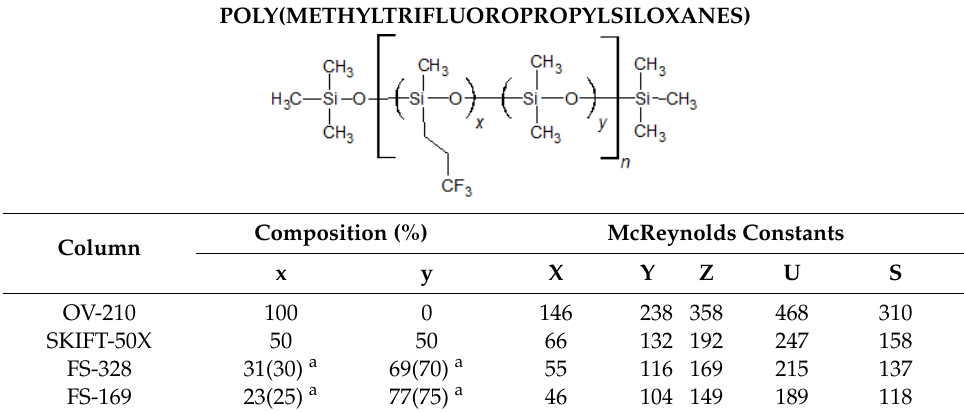
a nominal composition and in brackets that of the geometric model. 2. Molecular structure of poly(methyltrifluoropropylsiloxane) and poly(cyanoalkylmethylphenylsiloxane) stationary phases, and related McReynolds constants. POLY(METHYLTRIFLUOROPROPYLSILOXANES)